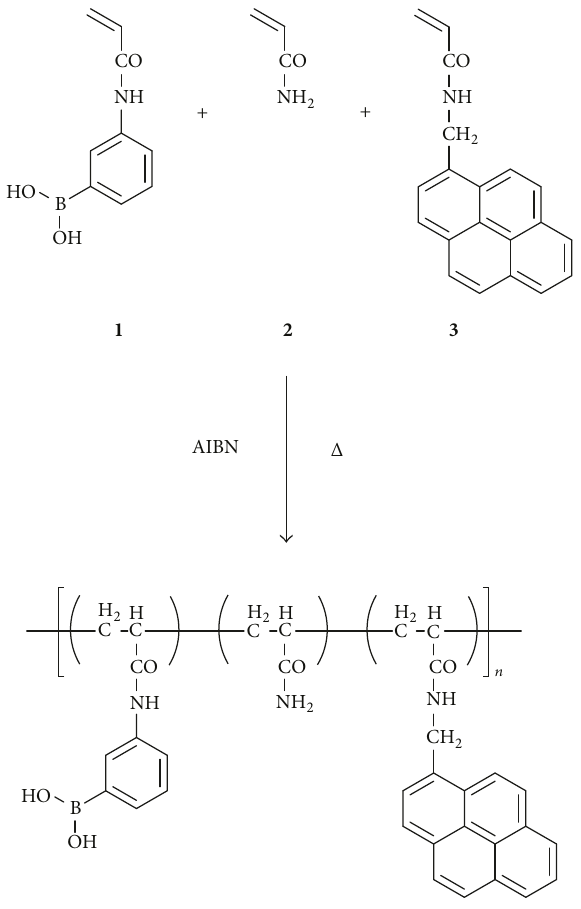
Scheme 2: Preparation of fluorescent boronic acid